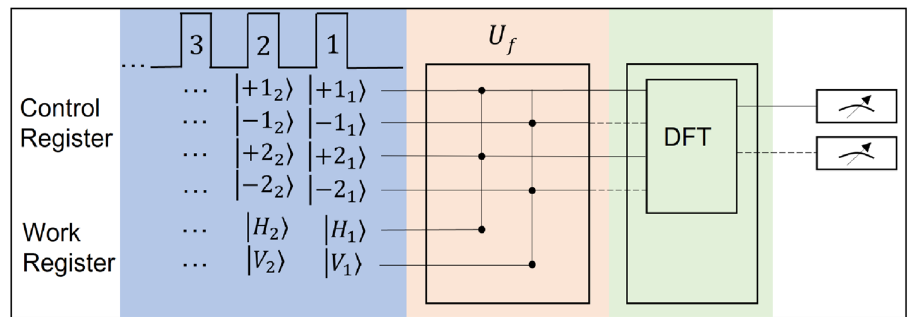
Figure 1. Circuit flow diagram for implementing Shor’s algorithm. The blue, pink, and green parts indicate the stages for initialization, modular exponentiation, and discrete Fourier transform, respectively. The blue arrow in MEF in this part refers to the polarization flip. The modular exponentiation is implemented across the control and the work registers by a unitary transform U f , before which one eigenstate of the work register is flipped (shown as the blue arrow) and after which the eigenstates across the two registers are distinctly entangled (shown by the black nodes). The two entangled states associated with separately passed on to the Fourier transform stage, respectively indicated by the solid and the dashed lines.